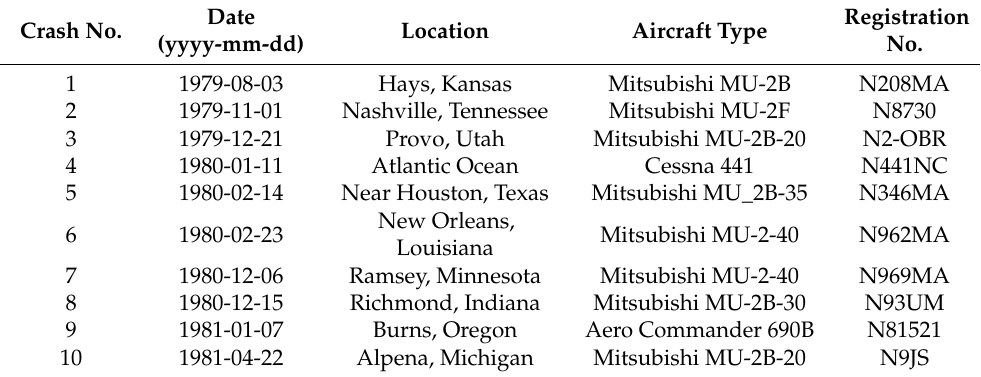
Table 1. Accidents investigated for pilot incapacitation. Crash